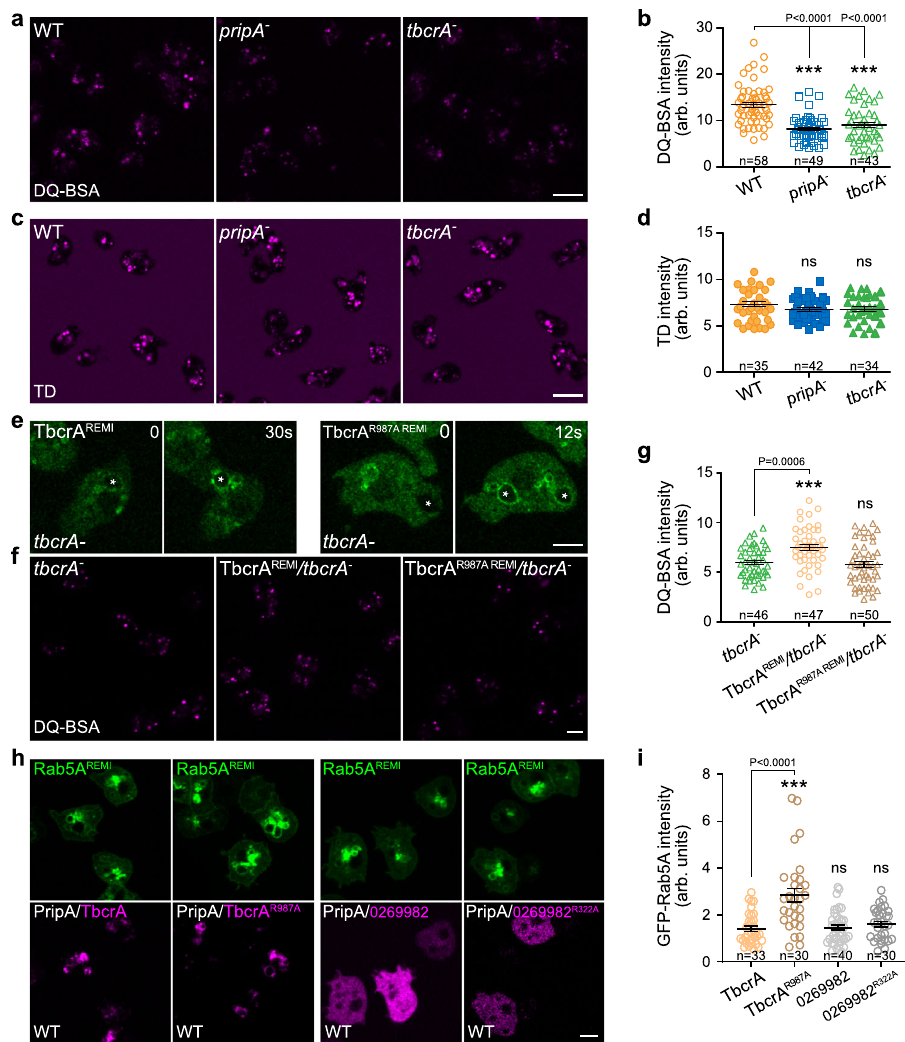
Fig. 8 The PripA-TbcrA complex promotes macropinosome maturation. a DQ-BSA degradation in WT, pripA − , and tbcrA − cells. Images were acquired after a 30-min incubation. b Quanti fi cation of DQ-BSA degradation. c TD uptake in WT, pripA − , and tbcrA − cells. Images were acquired after a 30-min incubation. d Quanti fi cation of TD uptake. e Localization of GFP-TbcrA and GFP-TbcrA R987A expressed from a stable copy integrated into the genome of tbcrA − . f DQ-BSA degradation in tbcrA − , GFP-TbcrA REMI / tbcrA − , and GFP-TbcrA R987A REMI / tbcrA − cells. Images were acquired after a 20-min incubation. g Quanti fi cation of DQ- BSA degradation. h GFP-Rab5A REMI /WT cells were transformed with vectors expressing PripA together with RFP-TbcrA, RFP-TbcrA R987A , RFP-DDB_G0269982, or RFP-DDB_G0269982 R322A . i Quanti fi cation of GFP-Rab5A signals on macropinosomes in the indicated cells lines. The scatter plots show data points with means and SEM. Signi fi cance was determined by one-way ANOVA with Dunnett posttest in all graphs. Scale bar = 5 μ m. Source data for b , d , g , i are provided in this